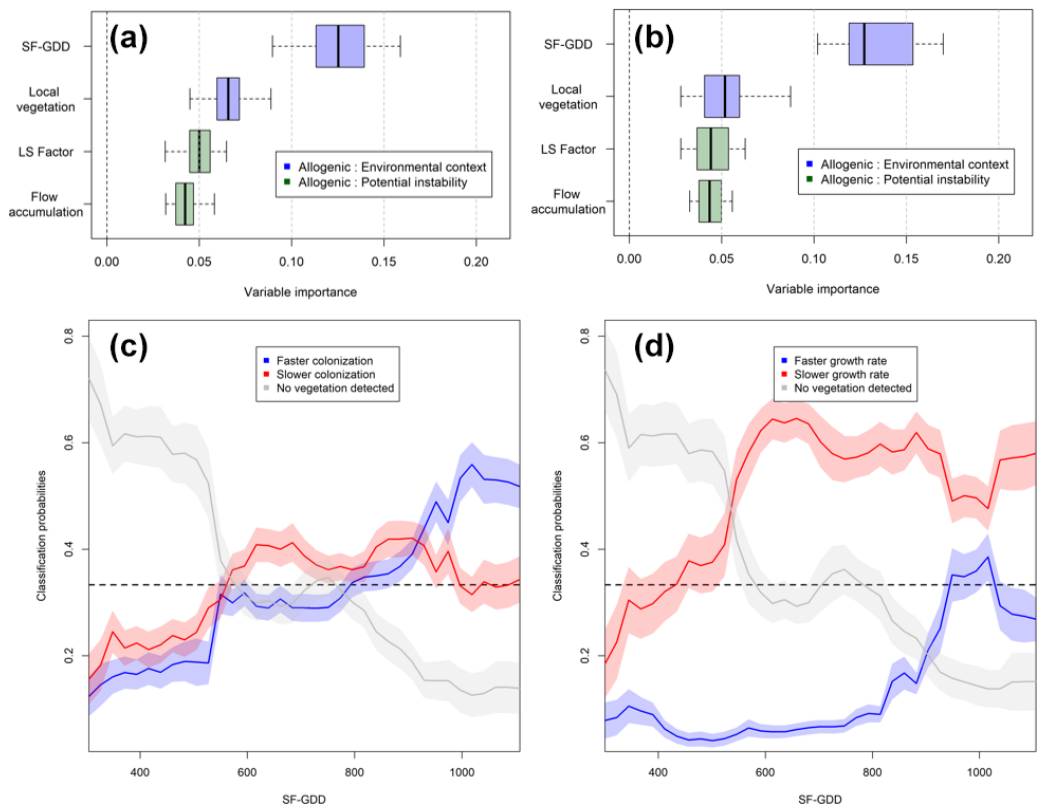
Figure 7. Variable importance from the random forest model considering the three classes of (a) TL and (b) GR. Partial dependency plots illustrating how SF-GDD affects class probability for the three classes of (c) TL and (d) GR. Table 1. Corrected Akaike information criterion and pseudo- R 2 values for two generalized least-squares (GLS) regression models including or not including the autocorrelated error